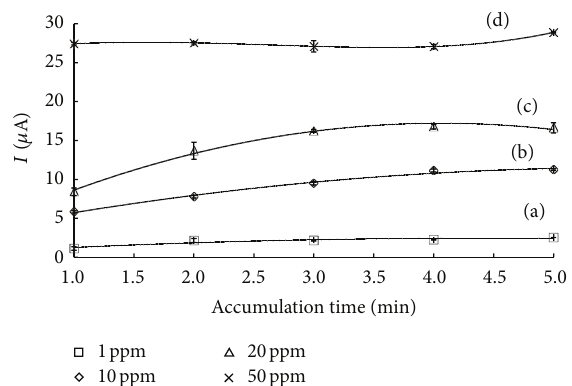
Figure 5: The effects of accumulation time (1 to 5 minutes) for the Acetabularia -CPE in Cu(II) standard with concentrations of (a) 1, (b) 10, (c) 20, and (d) 50 ppm. The applied conditions were deposition potential of − 300mV and scan rate of 100mV/s in 0.1MKNO 3